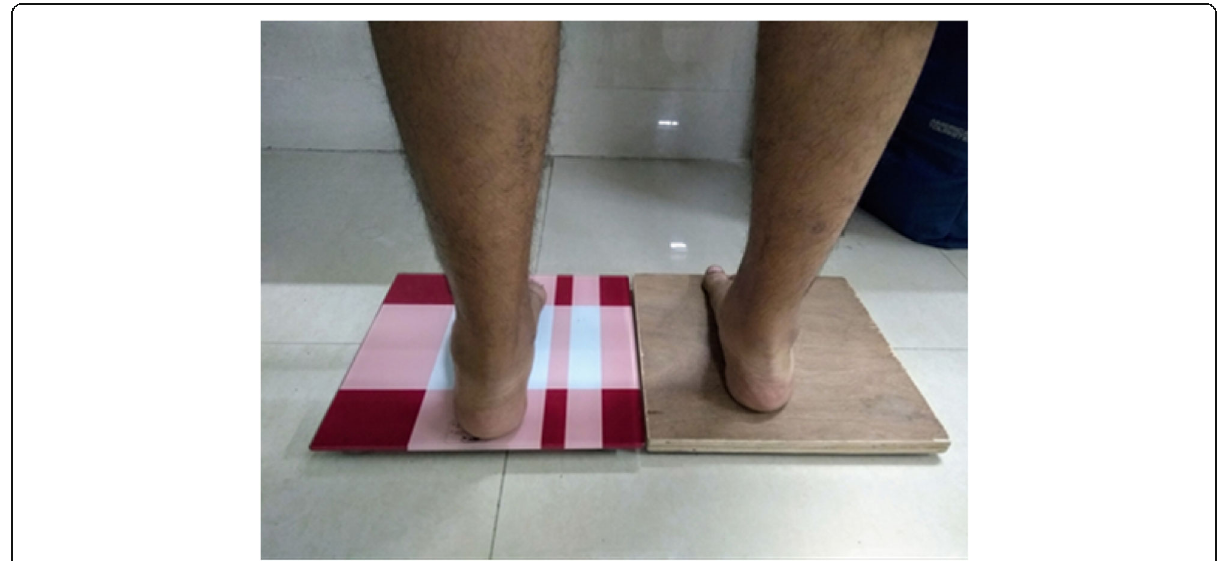
Fig. 3 Measuring weight-bearing asymmetry using digital weighing